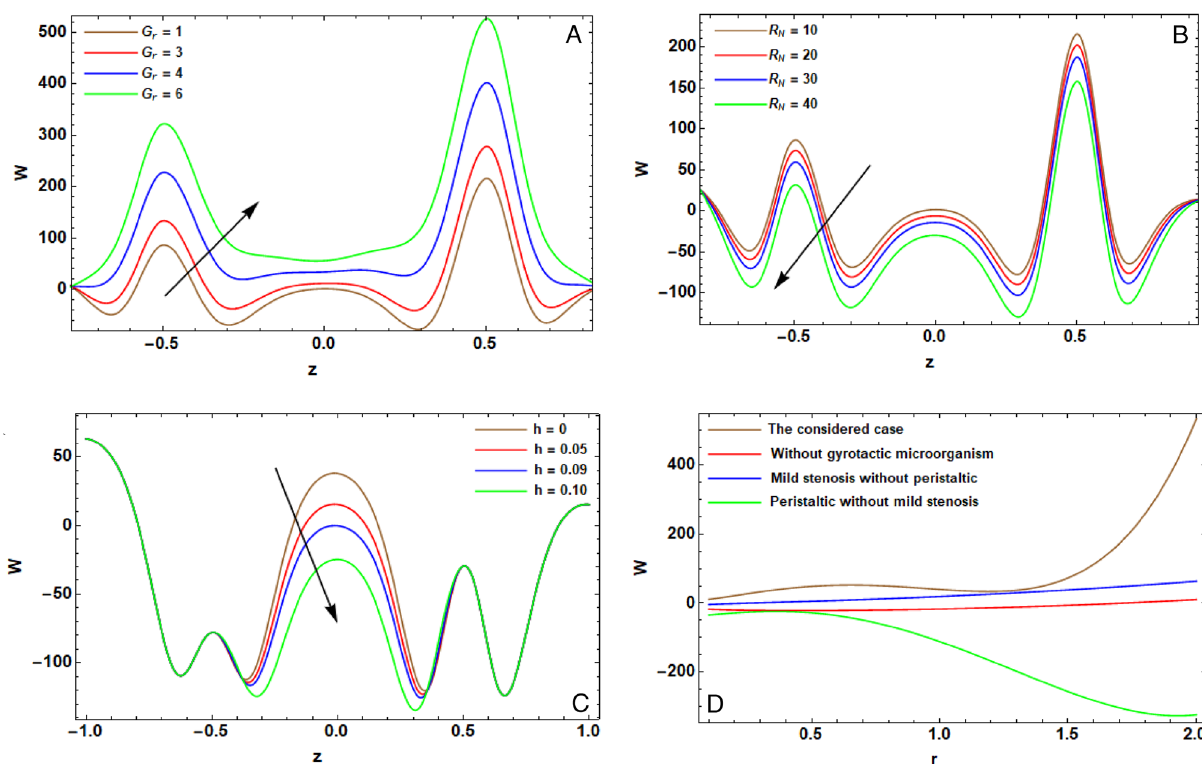
Figure 2. ( A ) implies alteration of w ( z ) for assorted amounts of G r . ( B ) implies alteration of w ( z ) for assorted amounts of R N . ( C ) implies alteration of w ( z ) for assorted amounts of h . ( D ) implies alteration of w ( z ) for particular status.